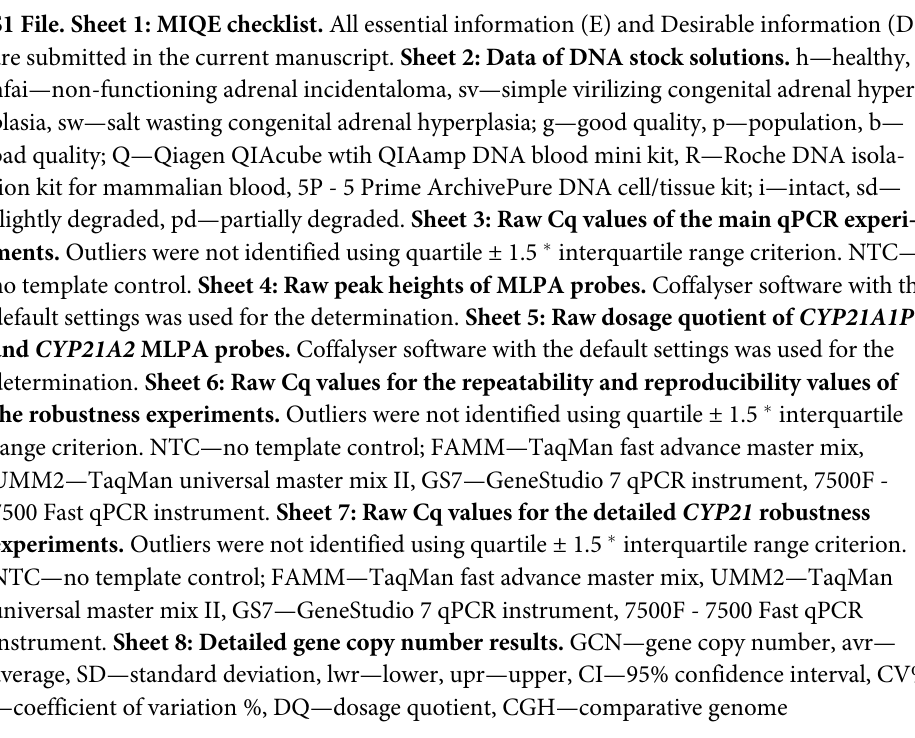
instrument. Sheet 8: Detailed gene copy number results. GCN—gene copy number, avr— average, SD—standard deviation, lwr—lower, upr—upper, CI—95% confidence interval,